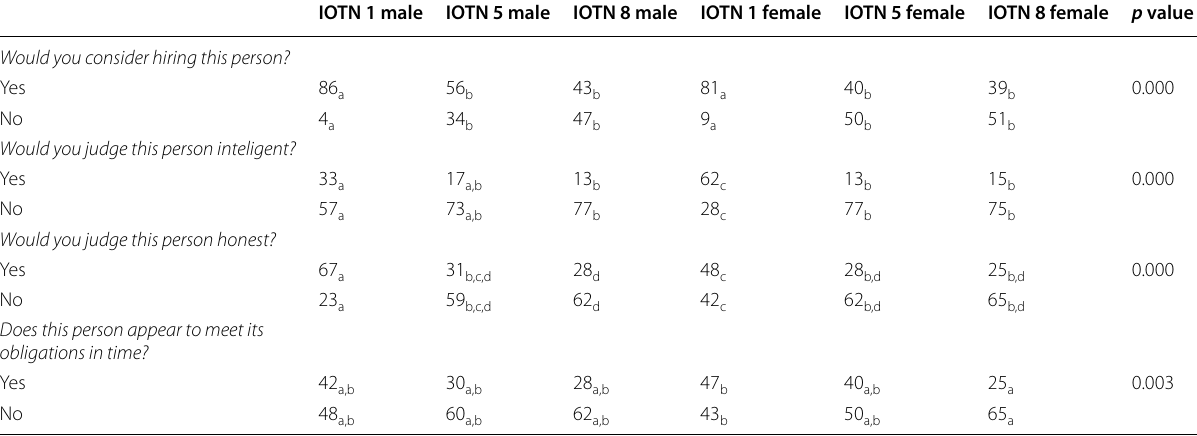
Statistical difference p < 0.05